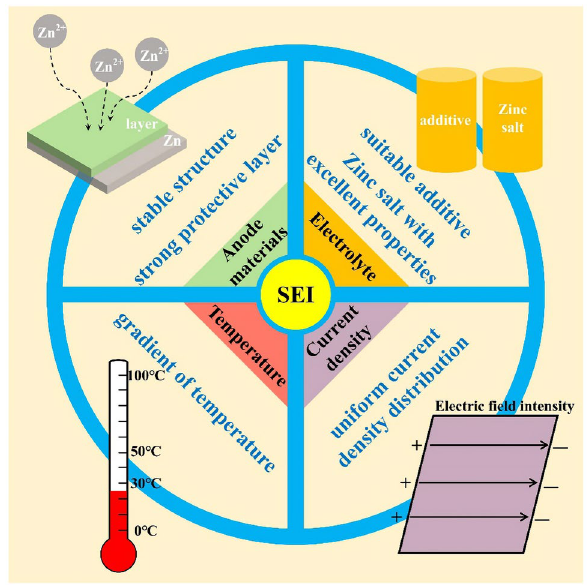
Fig. 6 Schematic diagram of factors influencing SEI